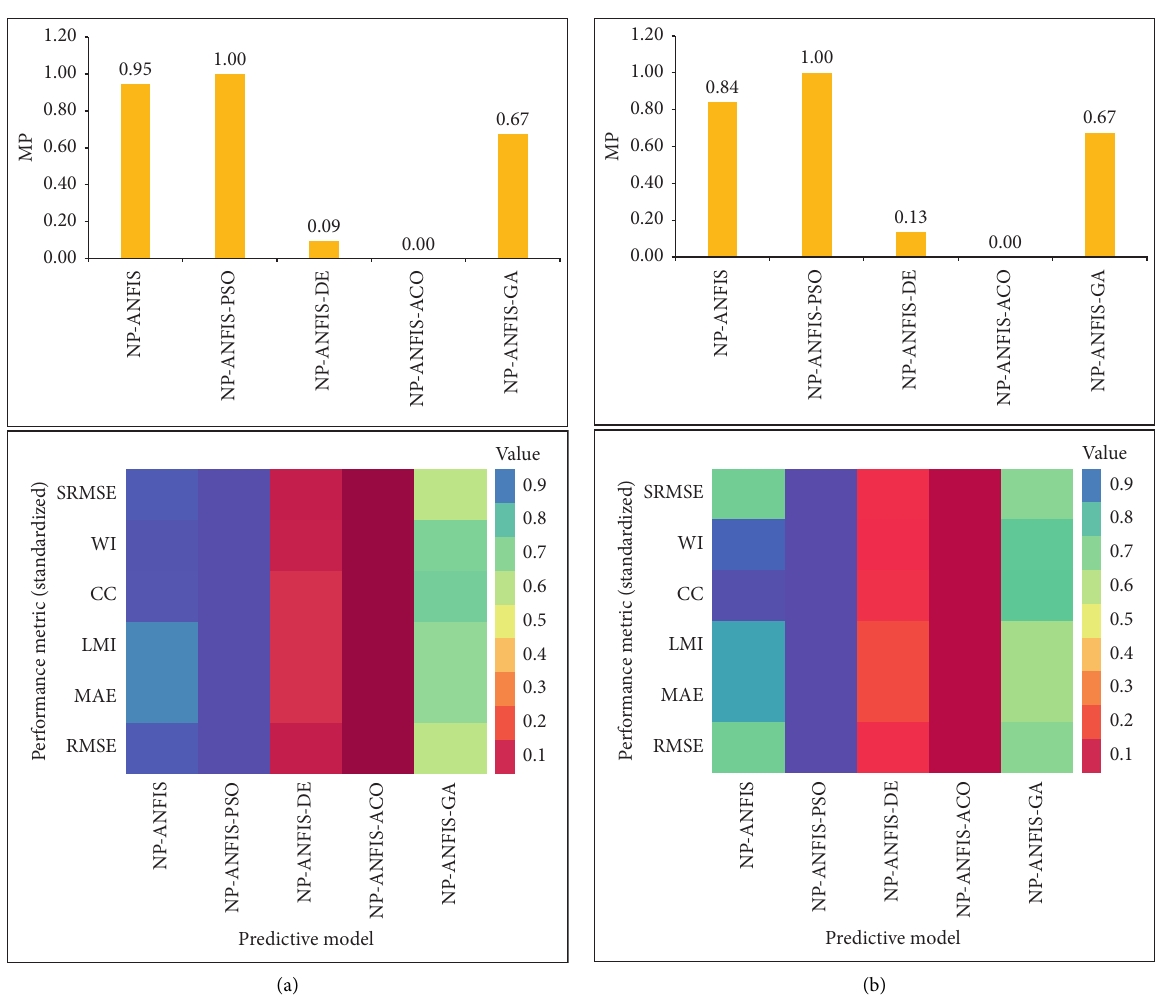
Figure 5: The mean performance index and heat graph presentations for the applied hybrid ANFIS models using the nonprocessed data (NP) scenario: (a) training phase and (b) testing